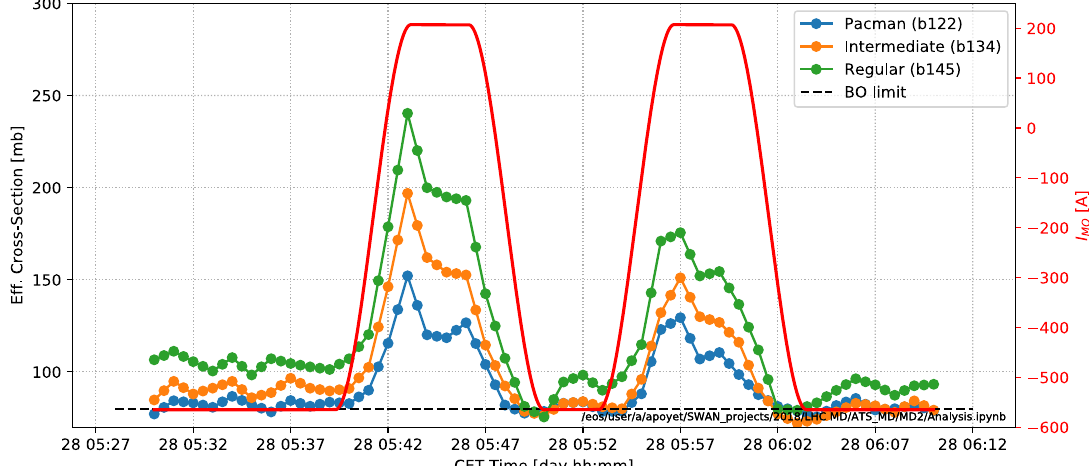
FIG. 13. 2018 flat ATS MD: lifetime (effective cross-section) vs MO current measured for a few selected bunches of Beam 1 with different BBLR collision schedule (full crossing angle of 200 μ rad). The machine was filled with 48 þ 12 þ 1 ¼ 61 nominal bunches, in particular a train of 48 bunches colliding at IP1 and IP5. During the MO scan, the Beam 2 bunch population was measured in the range of 0 . 9 – 1 . 0 × 10 11 p = b.